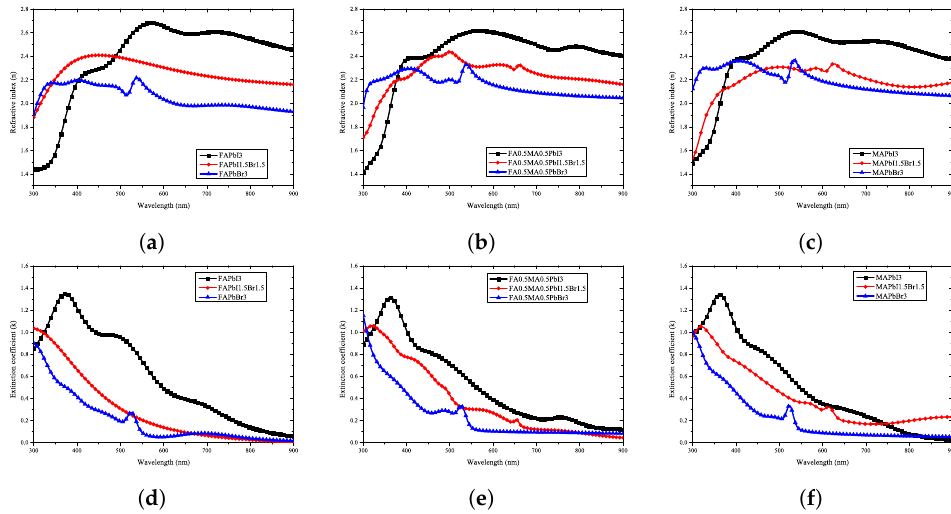
Figure 14. Results of optical properties with Br ratio of quaternary perovskite material: ( a – c ) refractive index, ( d – f ) extinction